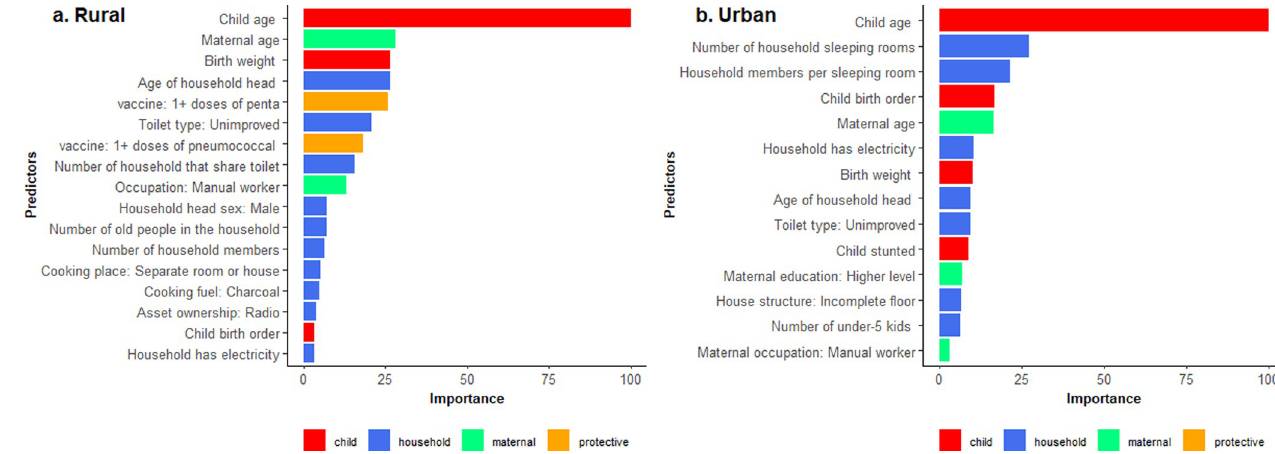
Fig 3. Key household and individual predictors of ARI in rural and urban areas identified through the analysis of 2006–2016 Uganda demographic health surveys data. The identification of variables is based on the best performing ML model, the GBM.